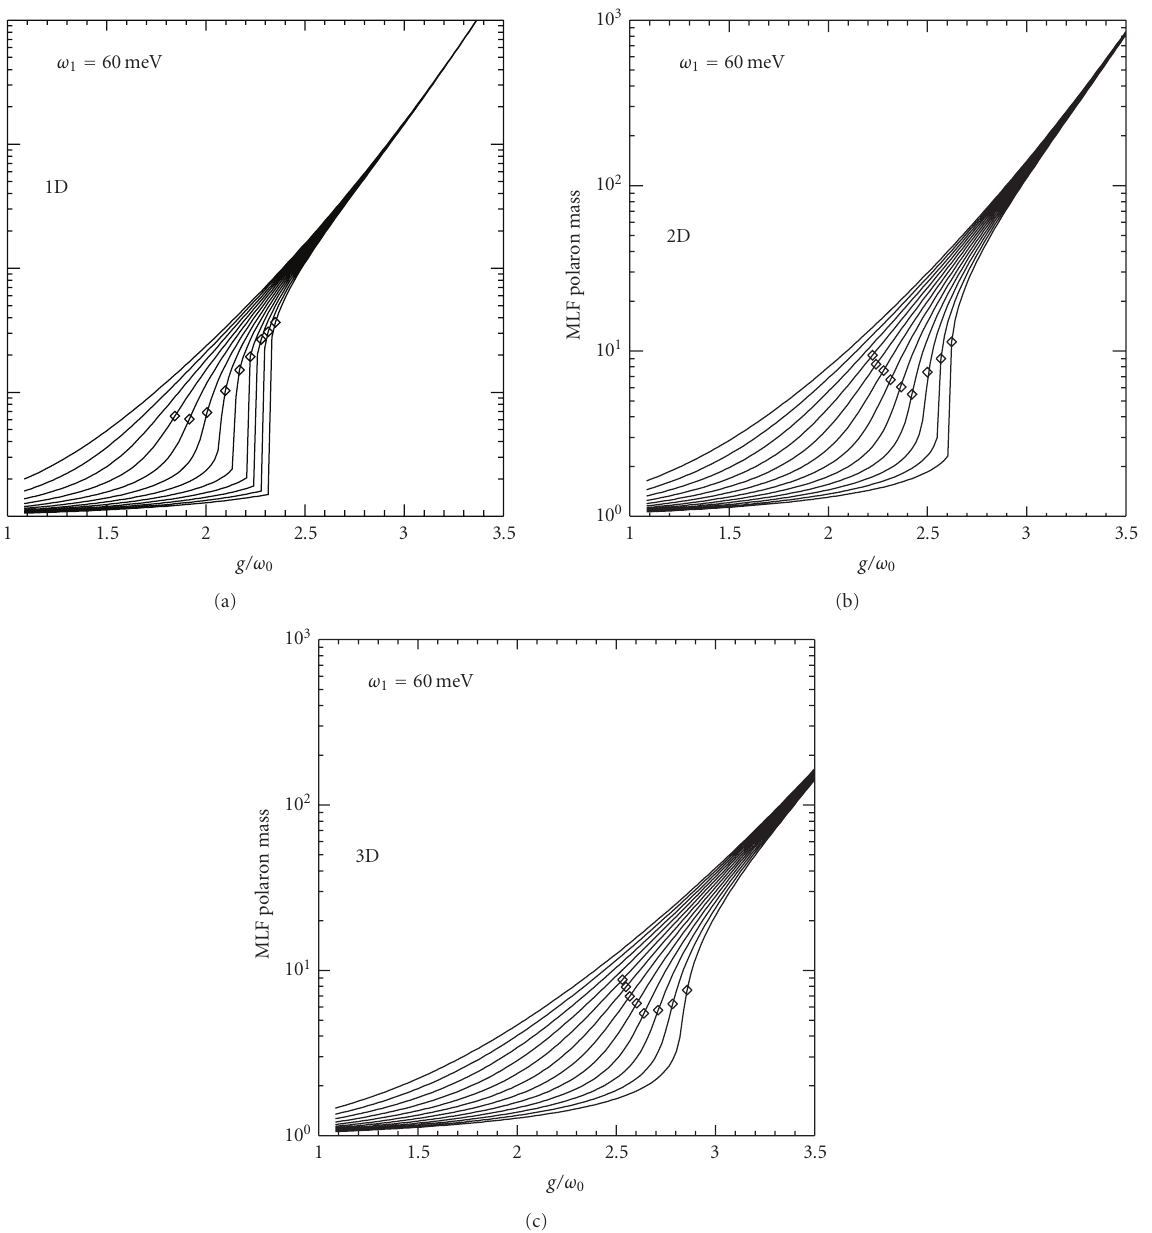
Figure 2: Ratio of the Modified Lang-Firsov polaron mass to the bare band mass versus e-ph coupling in (a) 1D, (b) 2D, and (c) 3D. A set of twelve zt/ω 0 values ranging from the antiadiabatic to the adiabatic regime is considered. From left to right: zt/ω 0 = 0 . 25,0 . 5,0 . 75,1 . 0,1 . 25,1 . 5,1 . 75,2 . 0,2 . 25,2 . 5,2 . 75,3 . 0. ω 0 = 100 meV. The diamonds mark the occurrence of the self-trapping